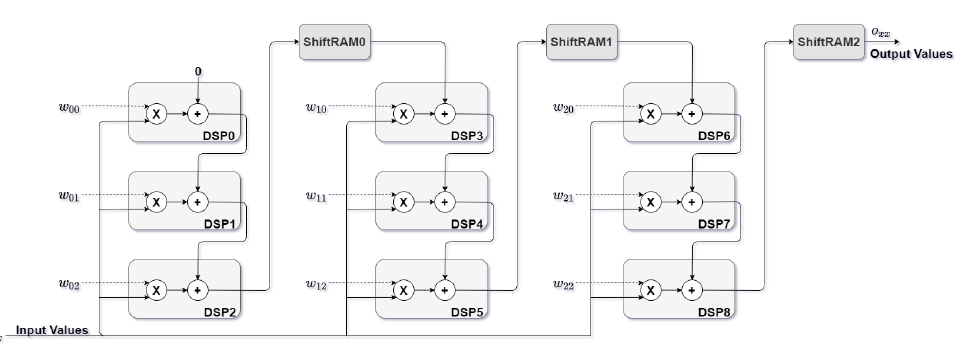
Figure 4. Processing element configuration for a 3 × 3